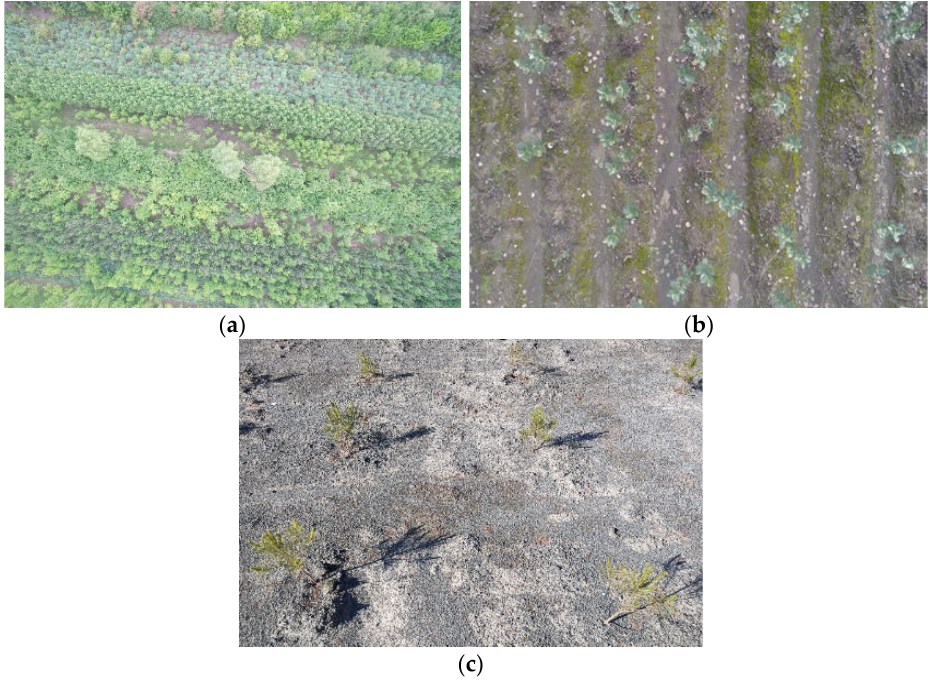
Figure 1. The original RGB images of the three types of seedlings, ( a ) dragon spruce, ( b ) black chokeberries, and ( c ) Scots pine.